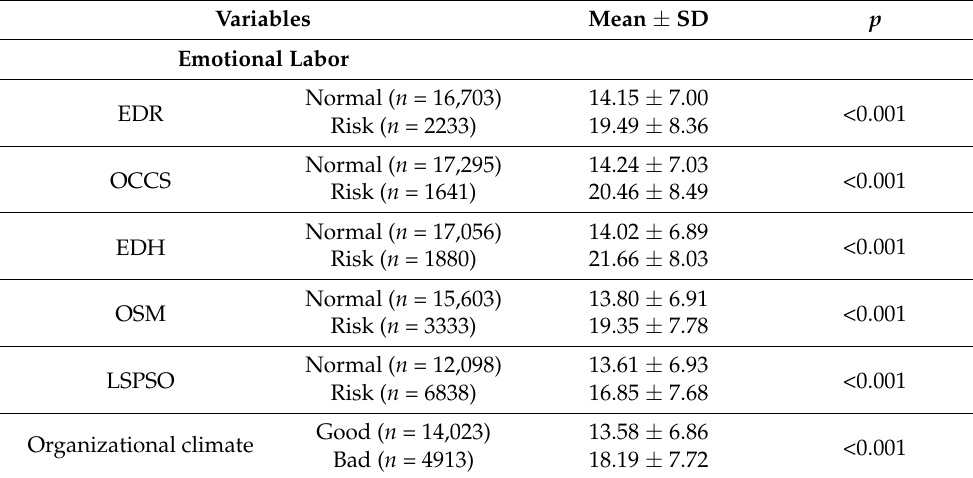
Table 2. Mean values and standard deviations (SD) of burnout according to the five sub-scales of emotional labor.